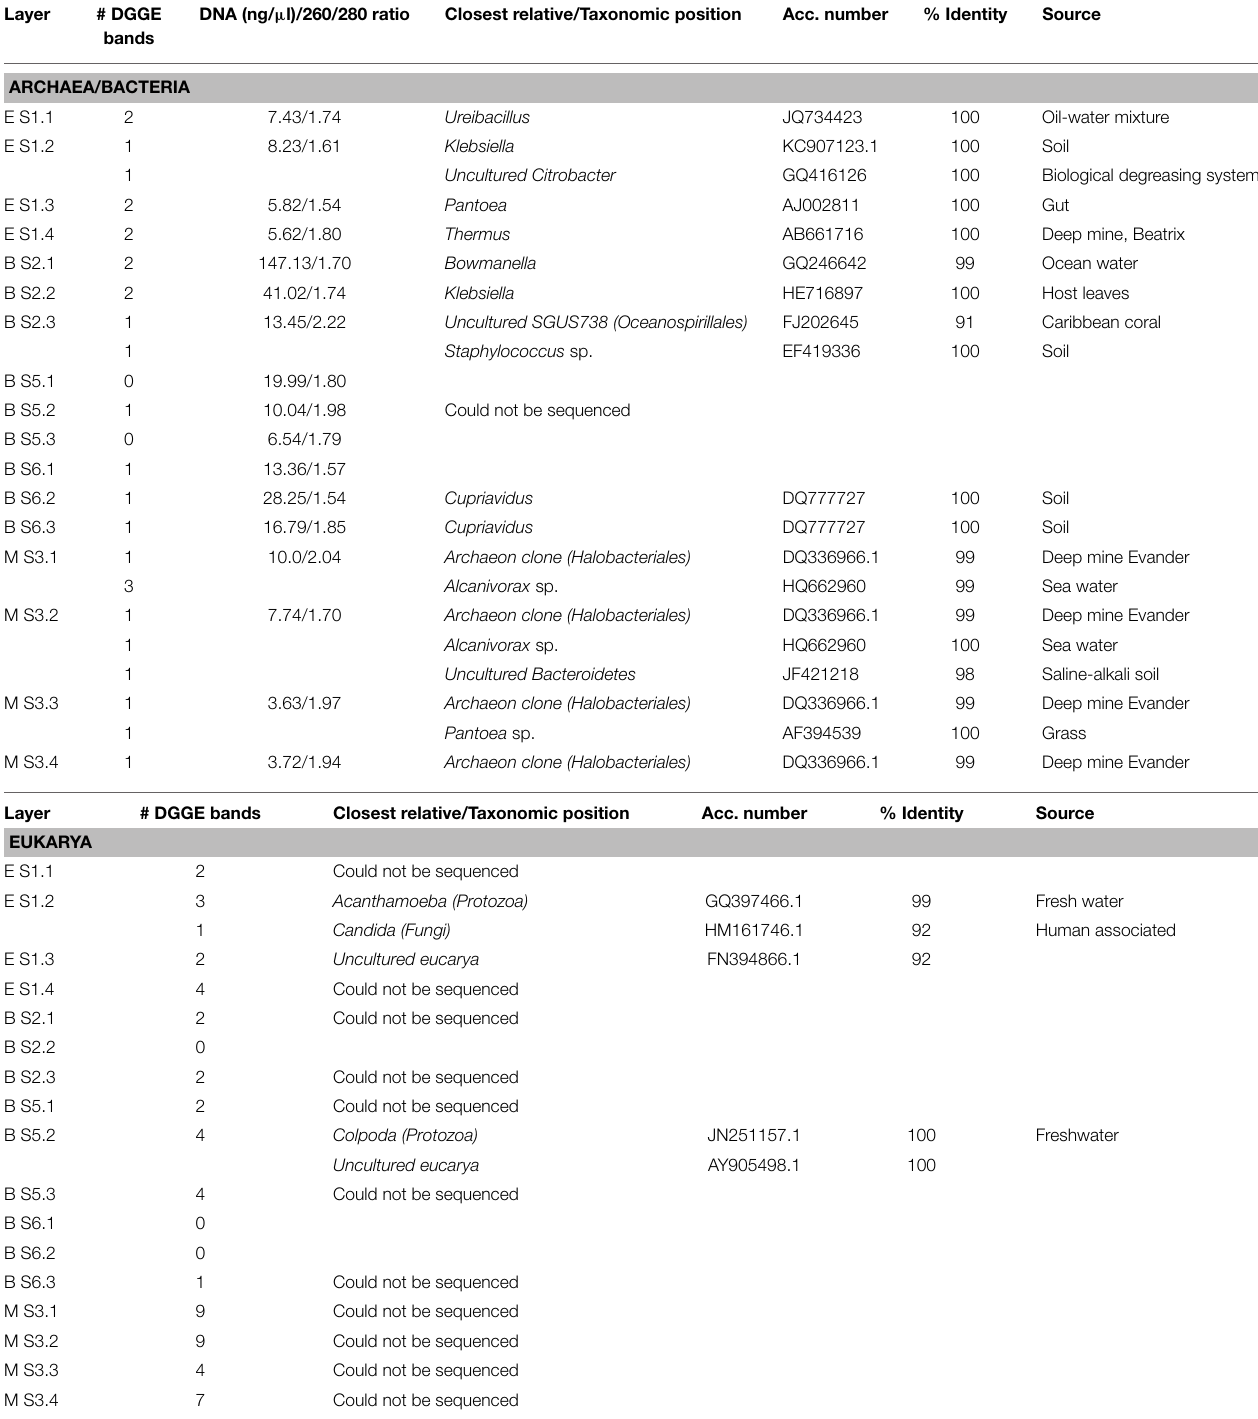
TABLE 1 | Archaeal, Bacterial, and Eukaryal DNA results from the stalactite extractions. Layer # DGGE DNA (ng/ µ l)/260/280 ratio Closest relative/Taxonomic position Acc. number % Identity bands